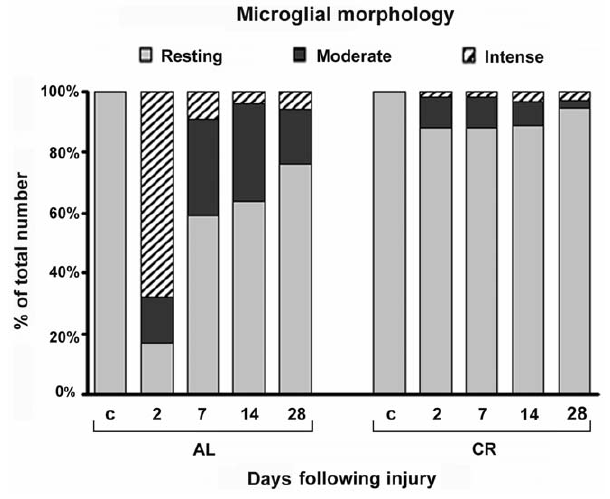
Figure 2. CR modulates microglial morphology in the perile- sioned area. Quantification of each morphological type of microglial cell (Table 2) is depicted as the percentage distribution per AL and CR groups as a function of time following injury. Percentage of both intense and moderate microglial cells was much higher in the AL group compared to the CR group at all time points. By far the greatest percentage of intense microglial cells was observed in the AL group on the 2 nd day following injury (83%). In the CR group the percentage of activated microglia (both intense and moderate ) did not exceed 15% of the microglia population. c – physiological control; 2, 7, 14, 28 – days